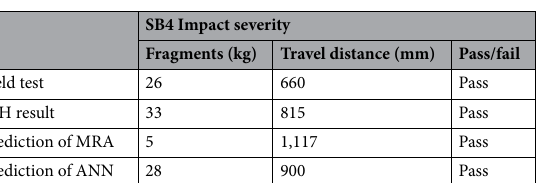
Figure 13. Comparison of field test and SPH analysis.